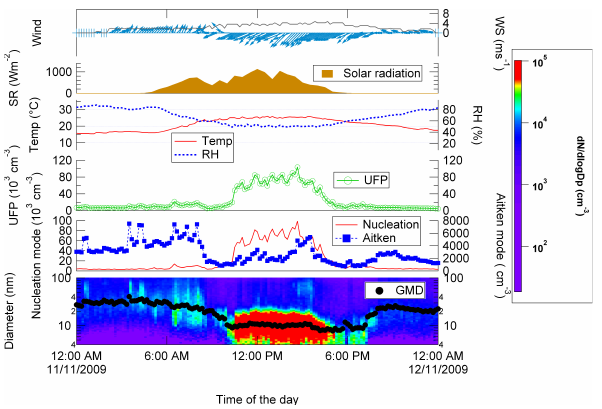
Fig. 11. The nucleation bursts measured on 11 November 2009. From bottom to top, the parameters are: (i) Geometric median di- ameter (GMD); (ii) Particle number concentration of nucleation and Aitken mode particles; (iii) Particle number concentration of ultra- fine particles (UFP); (iv) Temperature and relative humidity; (v) So- lar radiation; and (vi) wind direction and